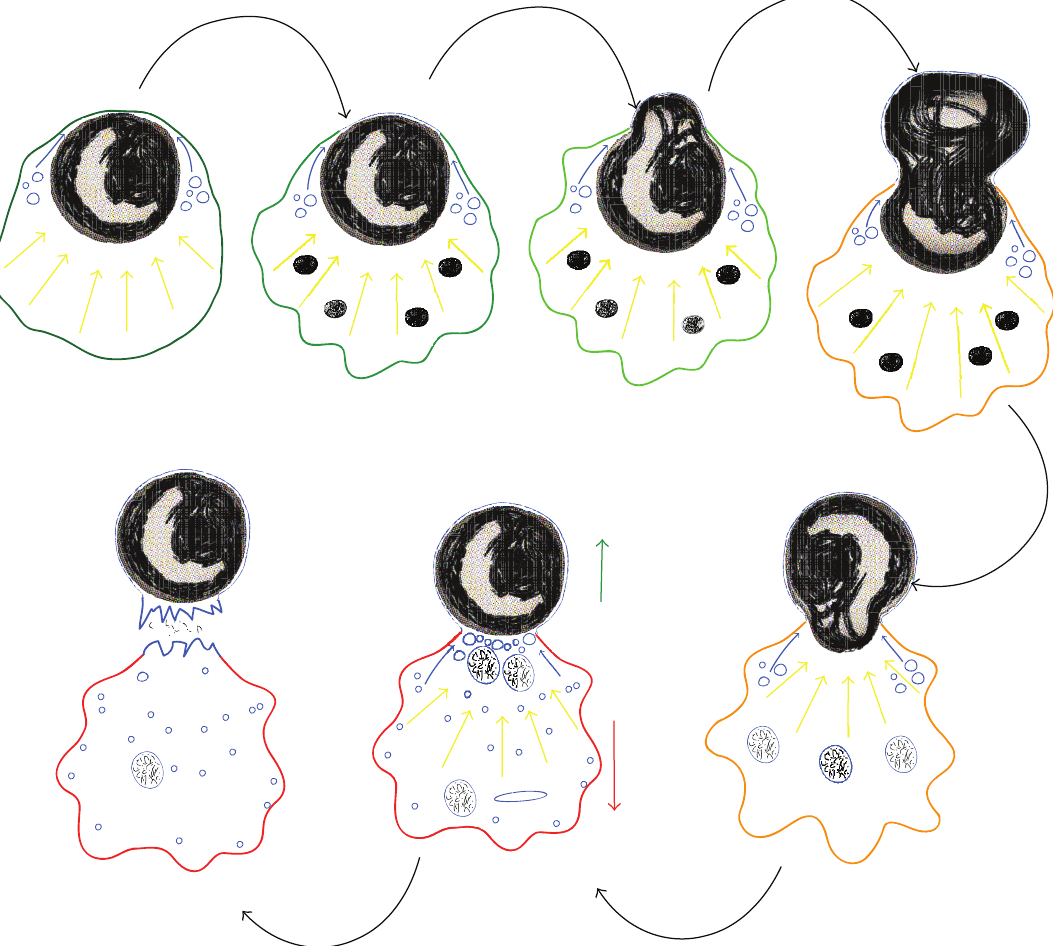
Figure 2: Model of enucleation . A schematic representation of the enucleation process in mammals is shown. Yellow arrows denote the direction of force applied over the nucleus by actin cytoskeleton. Blue arrows and vesicles denote the protein tra ffi cking, which directs the proteins that are destined to reach the pyrenocyte. The blue membrane adjacent to the nucleus is the part of the pyrenocyte membrane lacking spectrin, glycophorin A, actin cytoskeleton, and other reticulocyte-specific proteins that are di ff erentially sorted. The green arrow represents the direction of the force exerted on the pyrenocyte by a bound macrophage while the red arrow indicates the movement of the reticulocyte away from the center by lamellipodia and